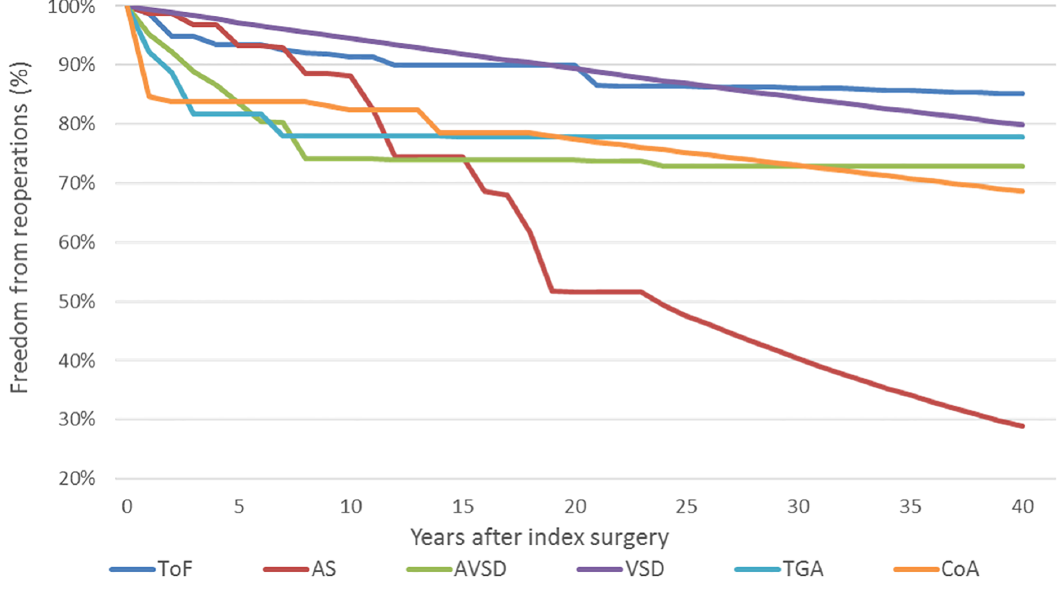
Fig 3. Observed and extrapolated freedom from reoperation data inputs. CHD—congenital heart defects, AS—aortic valve stenosis, VSD—ventricular septal defect, AVSD—atrioventricular septal defect, ToF—tetralogy of Fallot, TGA—transposition of great arteries, CoA—coarctation of the aorta.